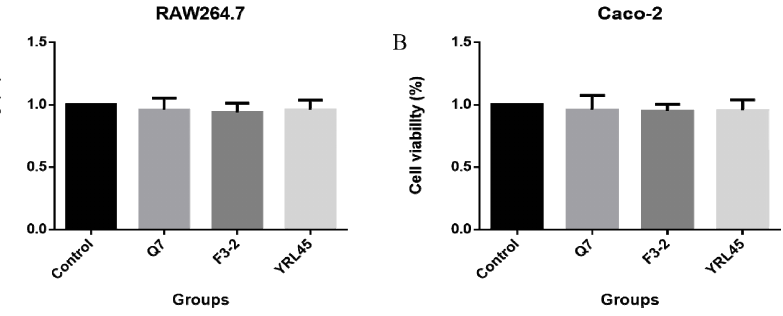
Figure 4. Effect of L. plantarum Q7, L. plantarum F3-2 and L. plantarum YRL45 on RAW264.7 ( A ) and